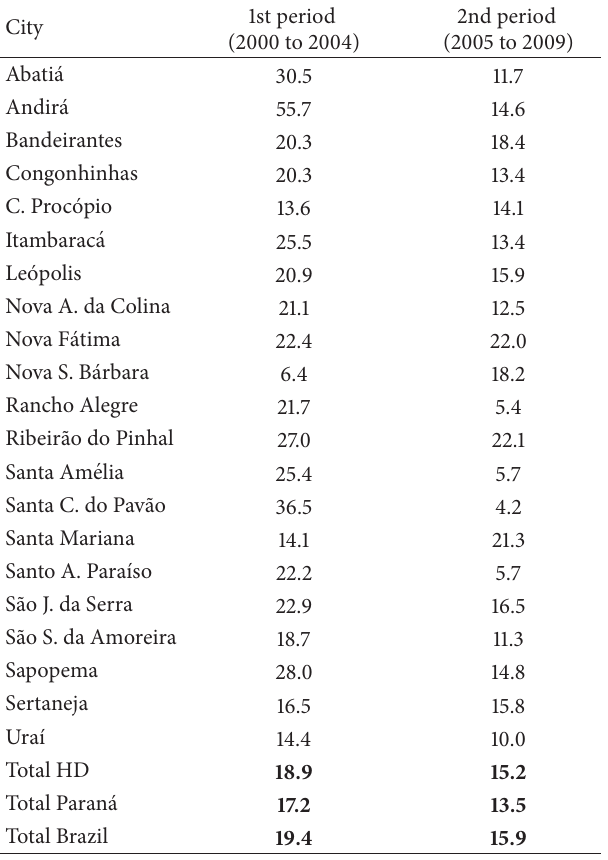
Table 1: Distribution of IMR means from the cities located at the 18th HD in Paran´a State from 2000 to 2004 and 2005 to